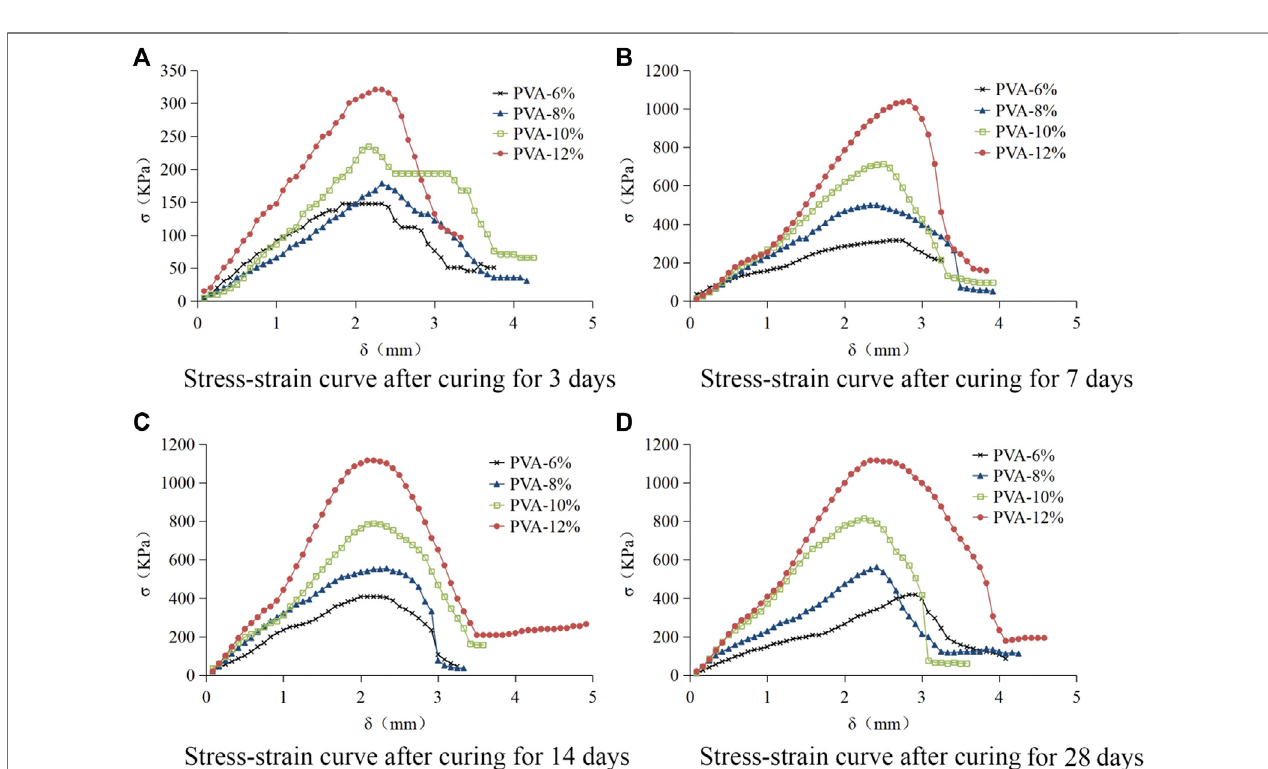
FIGURE 4 | Stress – strain curves obtained under different curing ages: (A) curing for 3 days. (B) curing for 7 days. (C) curing for 14 days. (D) curing for 28 days.